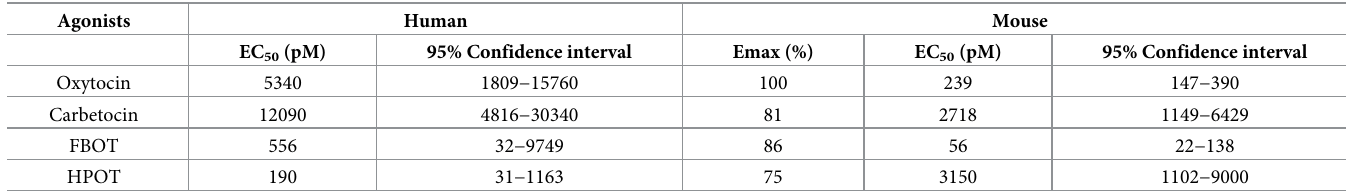
The effects on contraction were determined as the percentage of area under the curve (AUC) to the AUC of control contraction. Each experiment was performed in duplicate in two independent